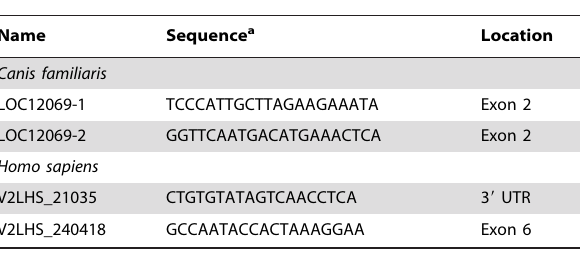
Table 2. HAVCR1 shRNAs.